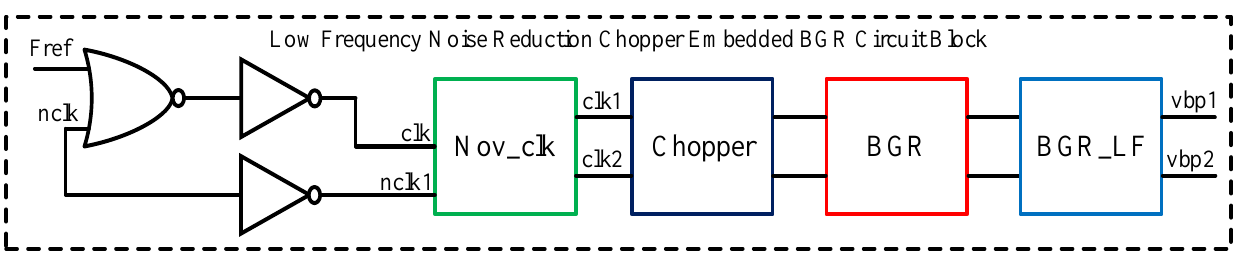
Figure 1. Block diagram of the chopper-stabilized BGR noise reduction scheme.